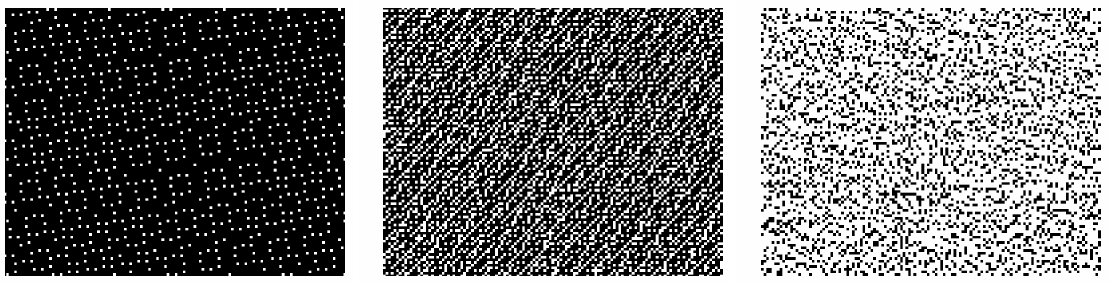
Figure 1: Successive images of Z 2 by discretizations of random matrices in SL 2 ( R ) , a point is black if it belongs to ( (cid:98) A k ◦ ··· ◦ (cid:99) A 1 )( Z 2 ) . The A i are chosen randomly and independently, using the singular value decomposition: they are chosen among the matrices of the form R angle θ and D t the diagonal matrix Diag ( e t , e − t ) , the angles θ , θ (cid:48) being chosen uniformly in [ 0 , 2 π ] and t uniformly in [ − 1 / 2 , 1 / 2 ] . From left to right and top to bottom, k = 1 , 3 ,